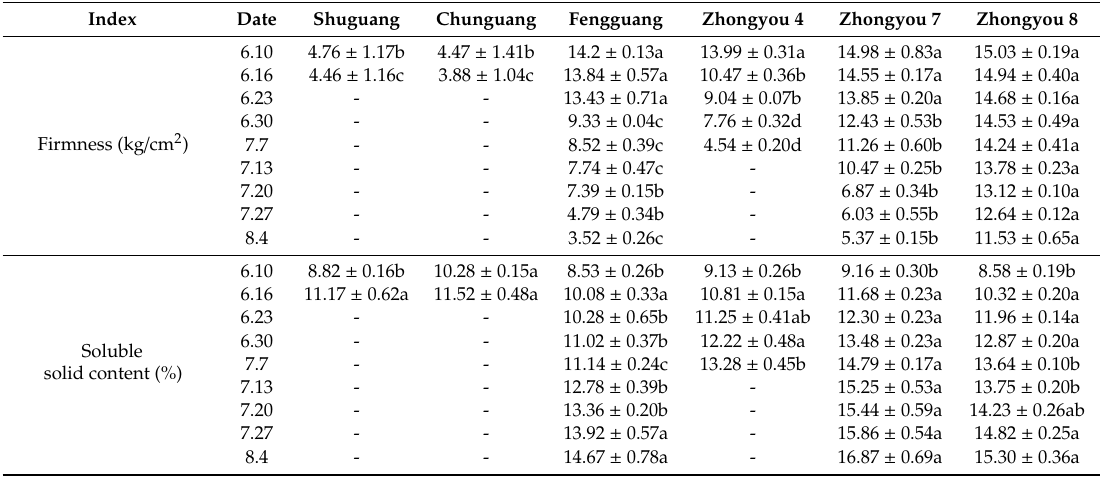
Table 5. The firmness and soluble solids content of nectarine